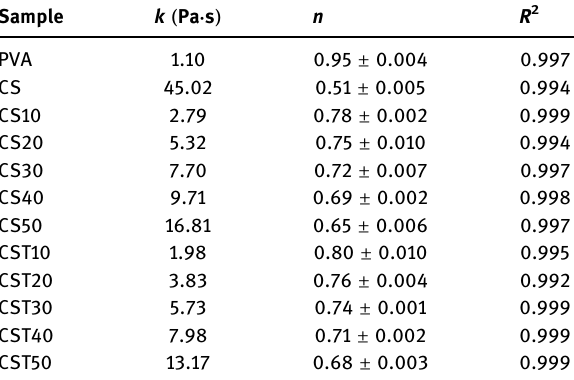
Table 2: Rheological parameters from the power law model of all samples in various conditions with and without T80 addition Sample